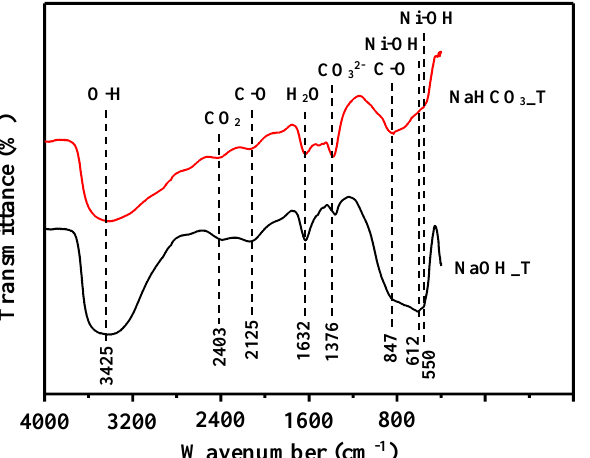
Figure 6. FT-IR spectra of Ni precursors (fresh catalysts) on the 400 °C-calcined LDH platelets of the samples NaOH_T and NaHCO 3 _T.